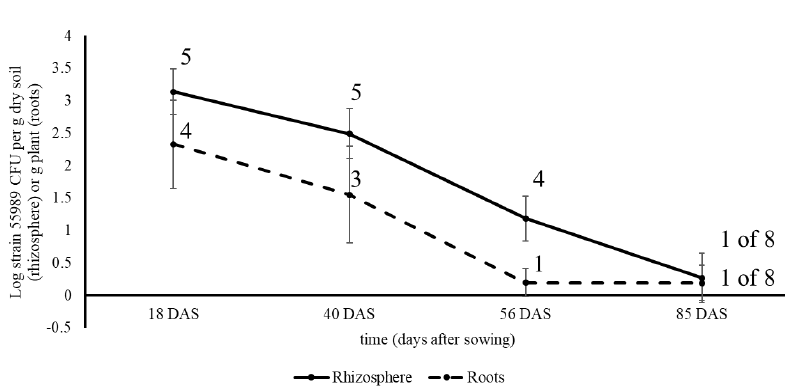
Figure 5. Colonization of roots and rhizosphere soil of pea plants by strain 55989, emerged from seeds treated with strain 55989 cells, under open field circumstances in 2015. Solid line, rhizosphere soil; dashed line, roots; numbers above symbols indicate the number of plants found positive for presence of strain 55989, of five replicate plants taken at 18, 40 and 56 DAS and of eight at 85 DAS. Microorganisms 2020 , 8 , x FOR PEER REVIEW The second field experiment, conducted in 2016, was focused on root zone and seed colonization by strain 55989 only, using five different strain 55989 and one control treatments. Seed loads with strain 55989 at 0 DAS were (in Log CFU per seed): 8.24, 7.36, 8.36, 8.04 and 6.83,